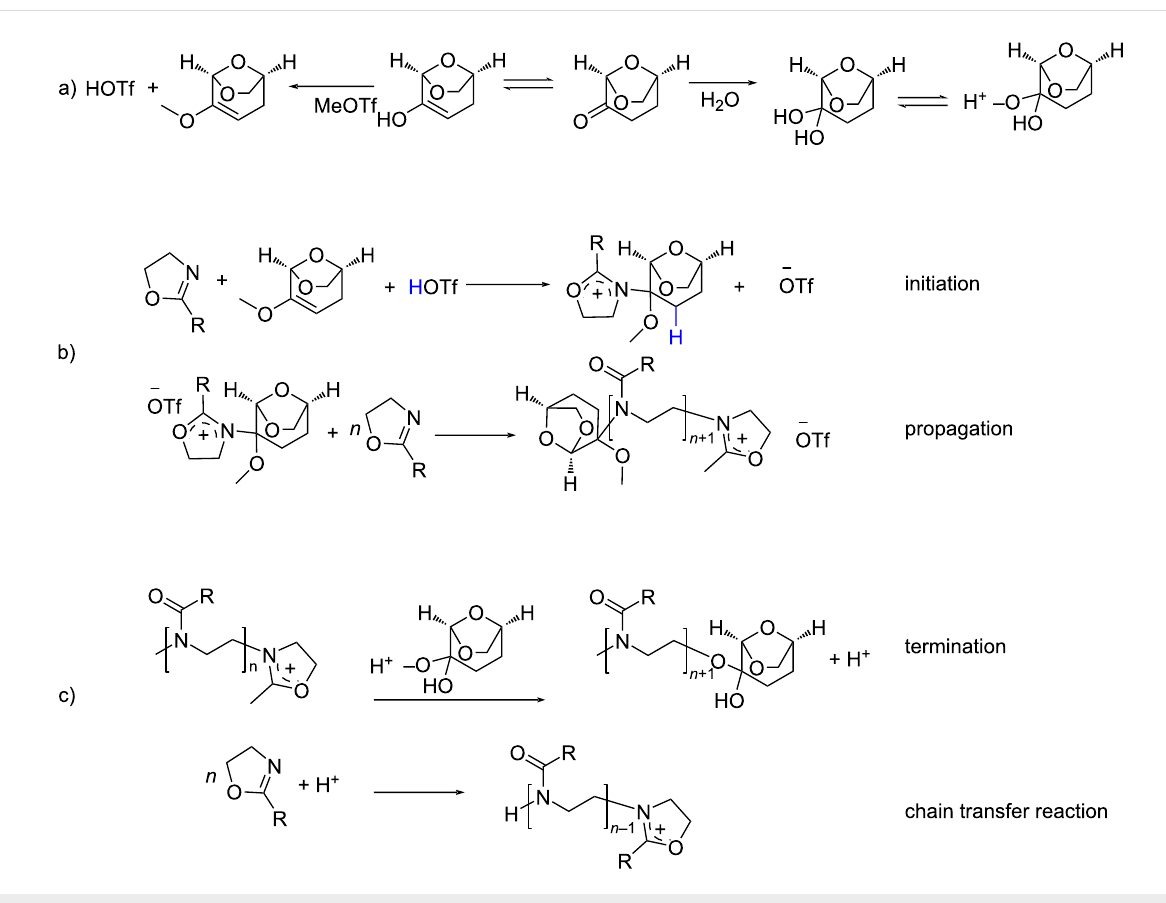
in the reaction temperature to 60 °C did not show significant improvements (Figure 6). The k p after initiation with MeOTf and EtOxMeOTf decreased considerably,